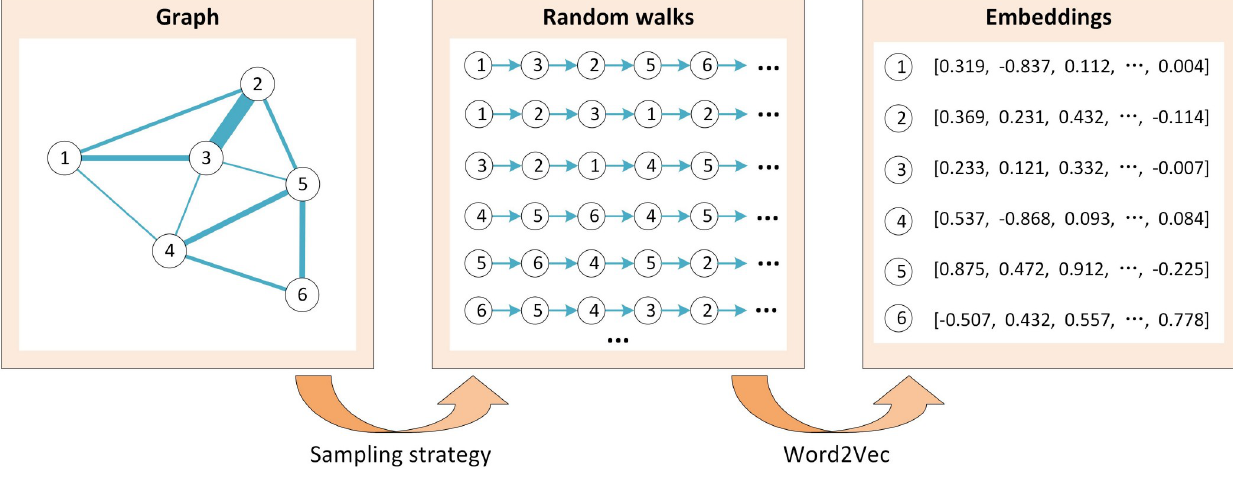
Fig 4. The framework of the Node2Vec model. Based on a certain sampling strategy, many random walks can be generated on the graph. Treating the nodes as “words” and the random walks as “sentences,” the embeddings of the nodes can be learned by feeding these “sentences” into the Word2Vec model.